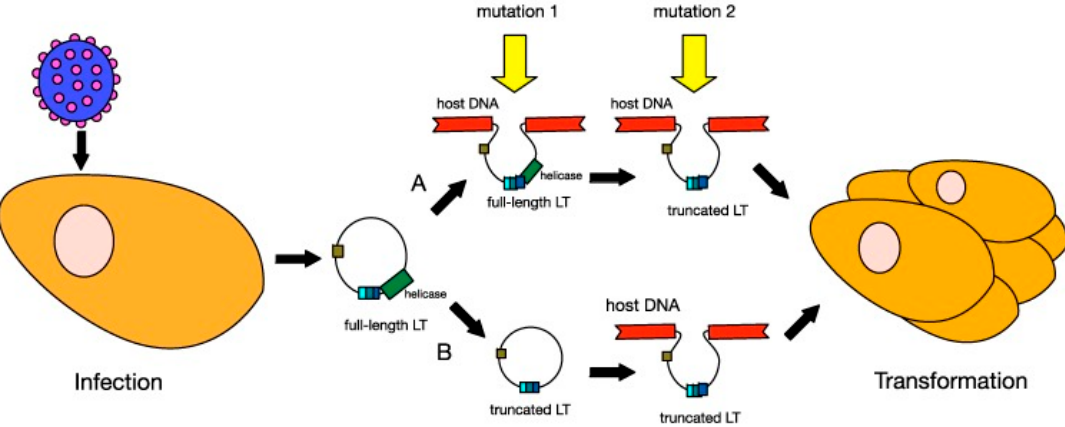
Figure 4. Models of MCPyV-induced Merkel cell carcinoma (MCC) tumourigenesis. MCPyV infection is thought to occur early in childhood of most people. Before tumourigenesis can occur, loss immunosurveillance must lead to proliferation of the virus. At least two mutations are needed before MCPyV can transform cells. In model A, the first mutation is thought to be the integration of the full-length viral genome into host DNA, while the second mutation is the truncation of LT. In model B, truncation of LT is thought to occur before integration. Either way, these changes in the virus lead to cellular transformation and tumour proliferation. Reproduced with permission from Stakaityt ė ,